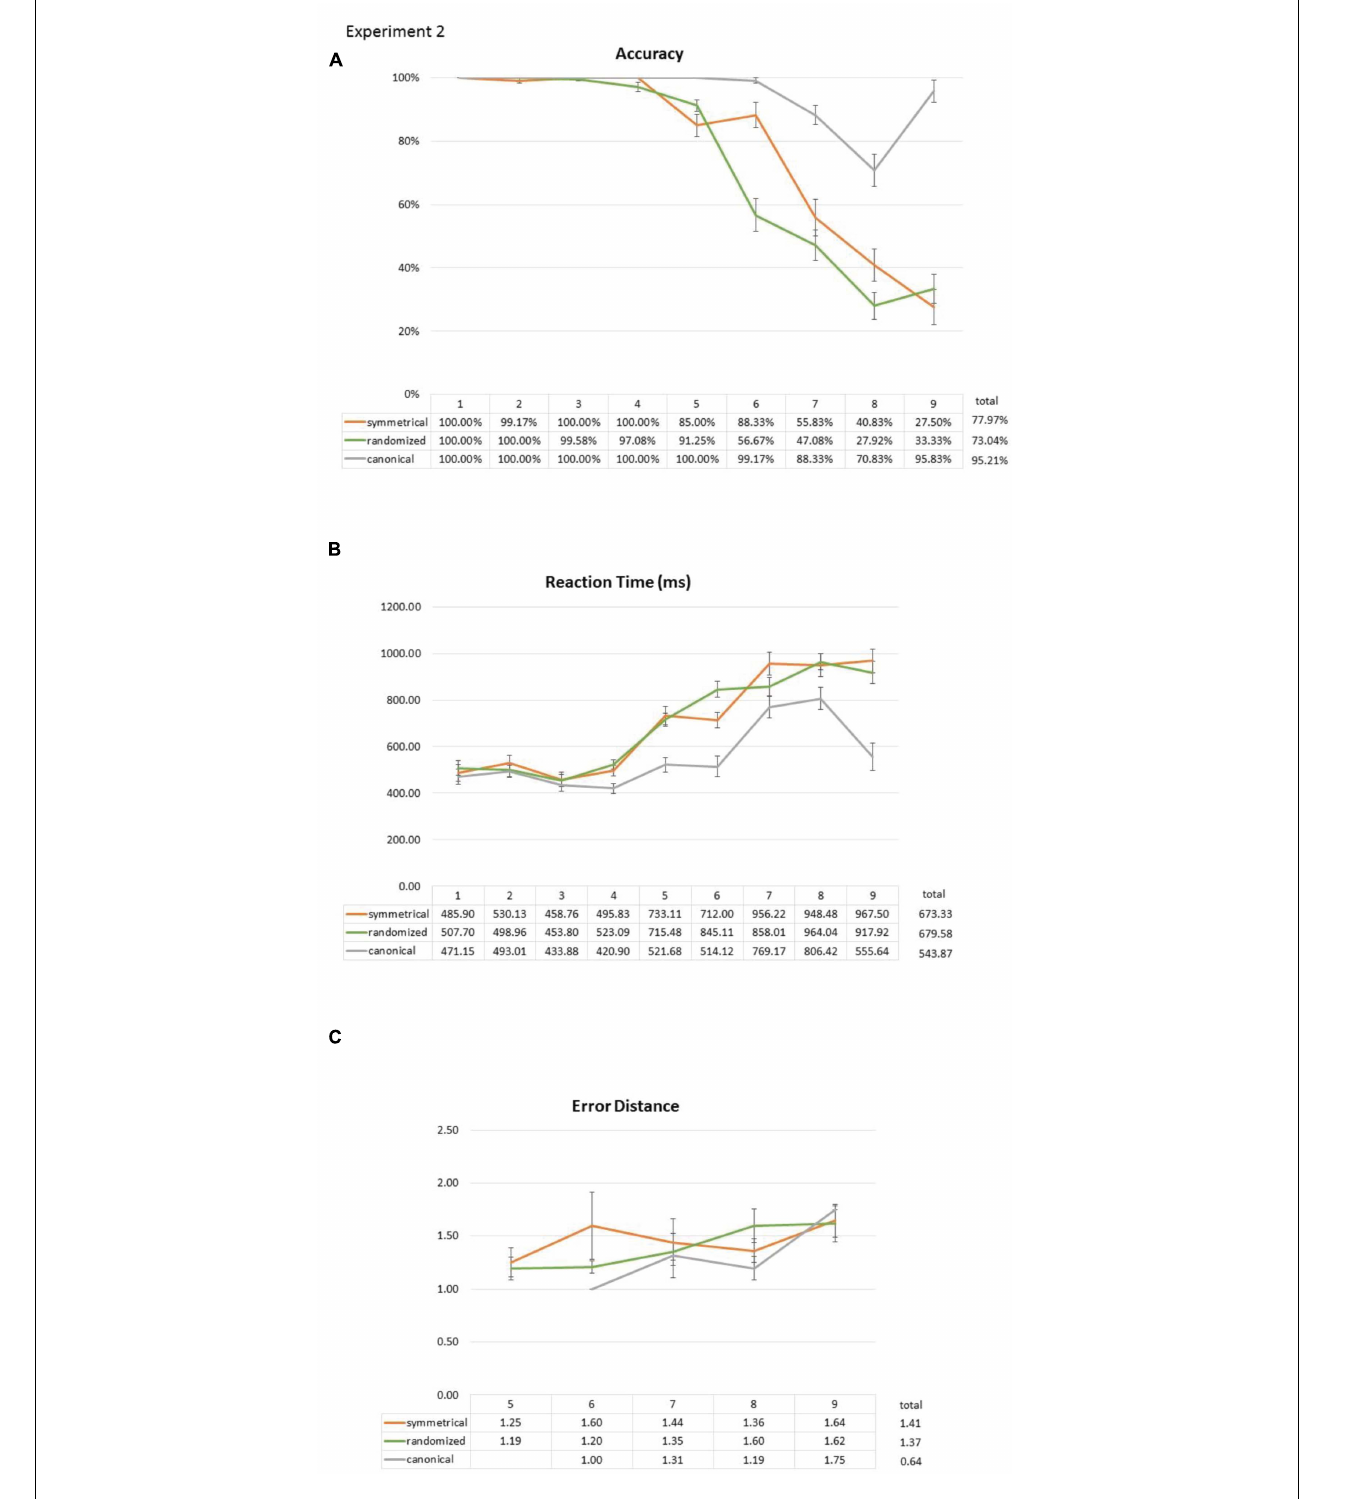
FIGURE 7 | Effect of the symmetry layout on subitizing accuracy (A) , RT (B) , and error distance (C) compared with canonical and randomized layouts in Experiment 2. Like Experiment 1, symmetry showed advantage over the randomized layout in both accuracy and RT. Canonical layouts, on the other hand, are, by far, better than symmetrical layouts across many set sizes in both accuracy and RT. These results show that: (1) unlike canonicality, symmetry is only facilitative at set size 6, and (2) even at set size 6, the effect of symmetry is sandwiched between canonical and randomized layouts. Error bars represent standard error of the mean.